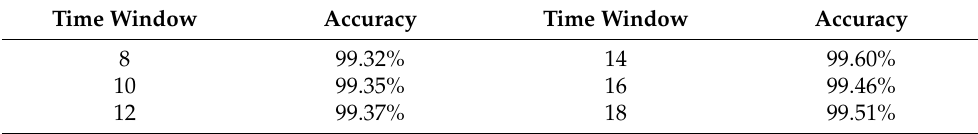
Table 6. Network performance under different encoding numbers.